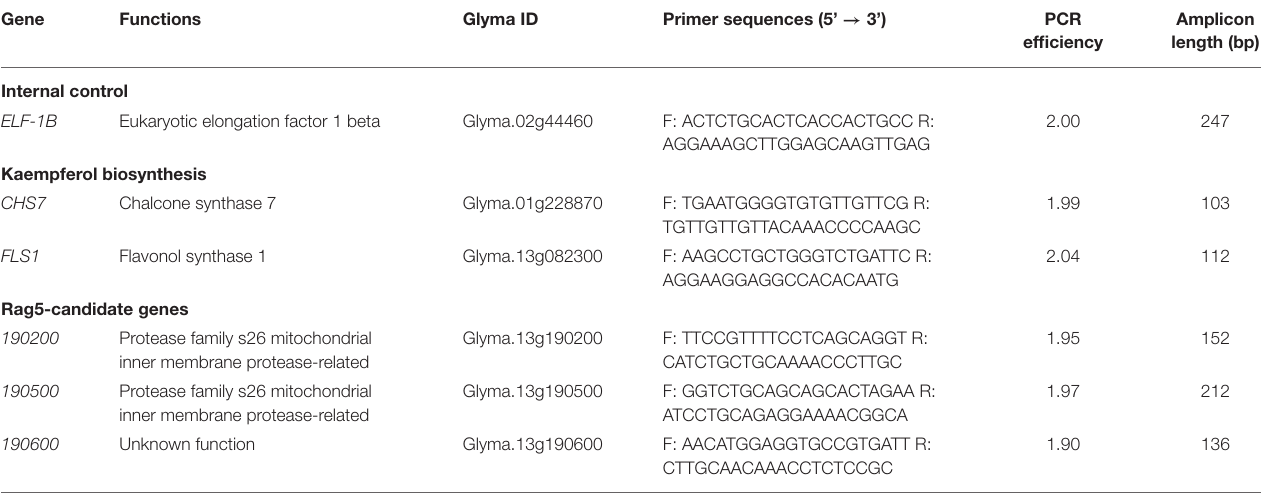
TABLE 1 | Quantitative real-time reverse transcribed PCR (RT-qPCR) primer pair sequences and corresponding PCR